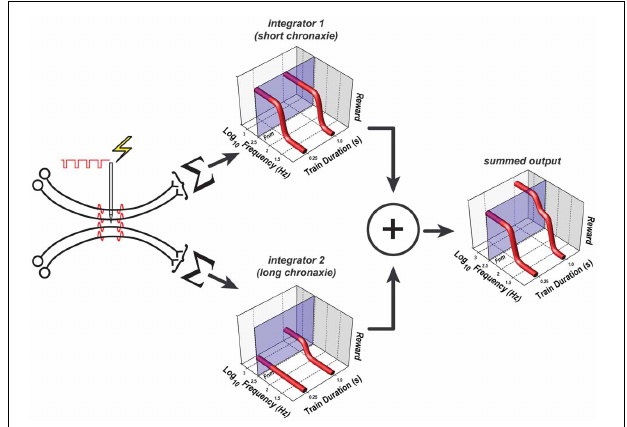
FIGURE 12 | The dual-integrator model. Only the components that differ from those in Figure 11 are shown; the remaining components are common to the single- and dual-integrator models. The rewarding effect arises from the direct activation of two subpopulations of neurons, each of which projects to a different spatio-temporal integrator; the weighted outputs of these two integrators are pooled. One integrator has a shorter chronaxie than the other, which renders it less sensitive to the reduction of the train duration from 1 to 0.25s. Note that the pulse-frequency axis is inverted: the frequency decreases from left to right. The translucent blue planes are positioned at F NearMax ( F nm ), the pulse frequency beyond which reward intensity approaches asymptote. At both the short and long train durations, the growth of reward intensity at the output of integrator 1 (upper 3D graph) is largely complete at pulse frequencies lower than F NearMax . Although reward growth at the output of integrator 2 is also largely complete at pulse frequencies lower than F NearMax when the train duration is 1s (lower 3D graph), reward growth has not yet begun at this pulse frequency when the train duration is 0.25s. Thus, reward fails to grow as a function of pulse frequency when the train duration is short, and the summed output of the two integrators (right-hand 3D graph) is lower at the short train duration than at the long. The parameters used to generate the reward-growth functions in Figure 12 are from the fit of the dual-integrator model to the data from rat C17 ( Figures 13 , 14